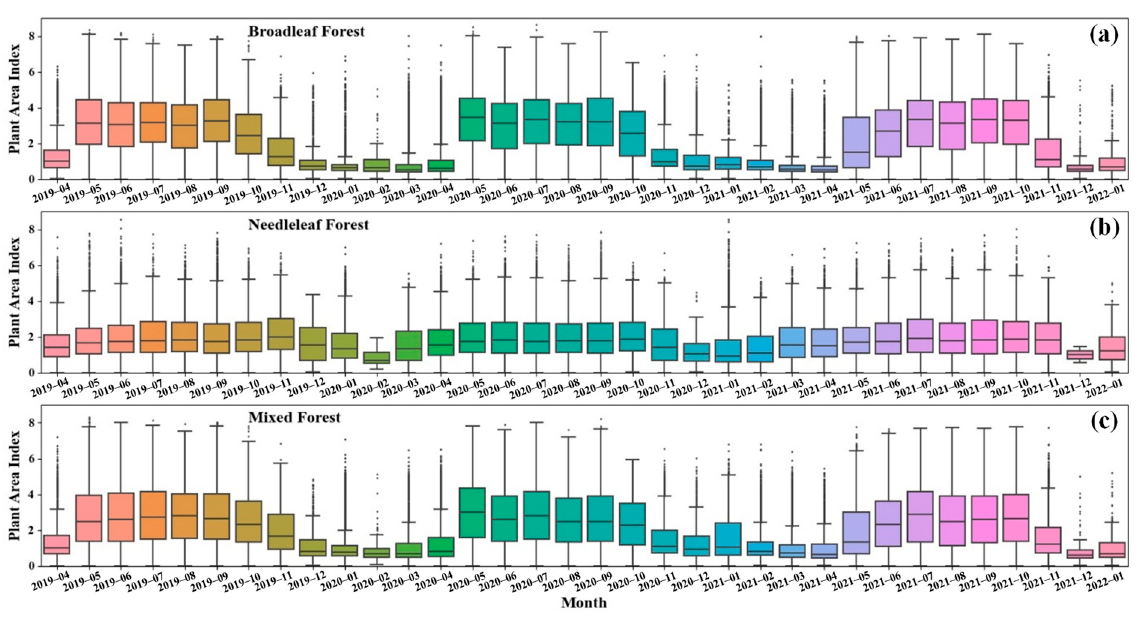
Figure 14. Boxplot of PAI on monthly acquisition time for ( a ) broadleaf, ( b ) needleleaf, and ( c ) mixed forest. The lower and upper hinge of the boxes indicates the 25th and 75th percentile of the data, respectively.